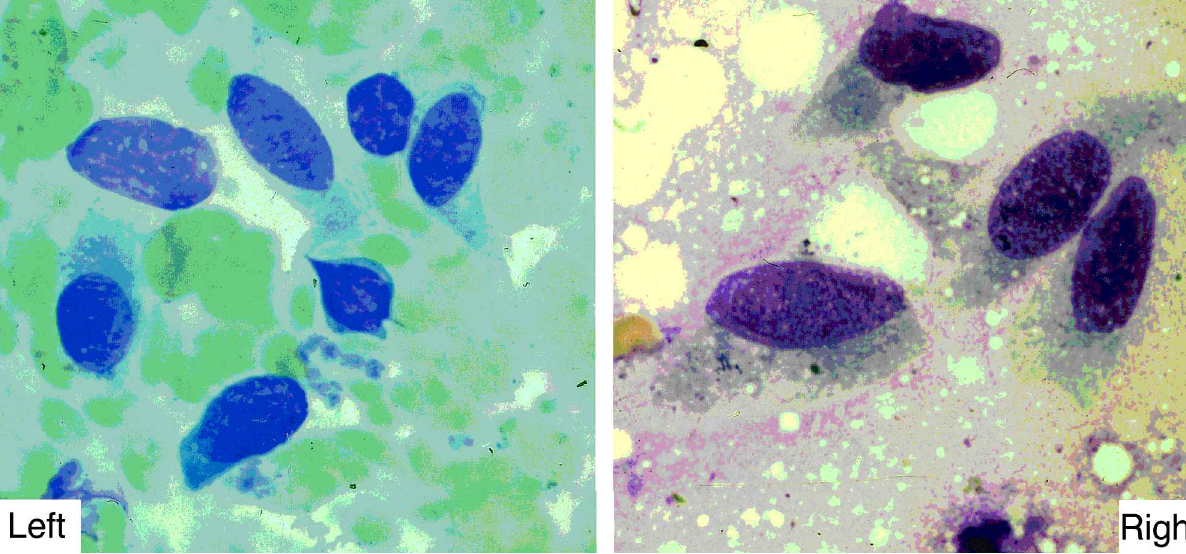
Fig. 5. A poor yield from two different spindle cell neoplasms. Left: monophasic synovial sarcoma. Right: desmoid ® bromatosis. Similar cellular shape and nuclear structure. A correct diagnosis is not possible .